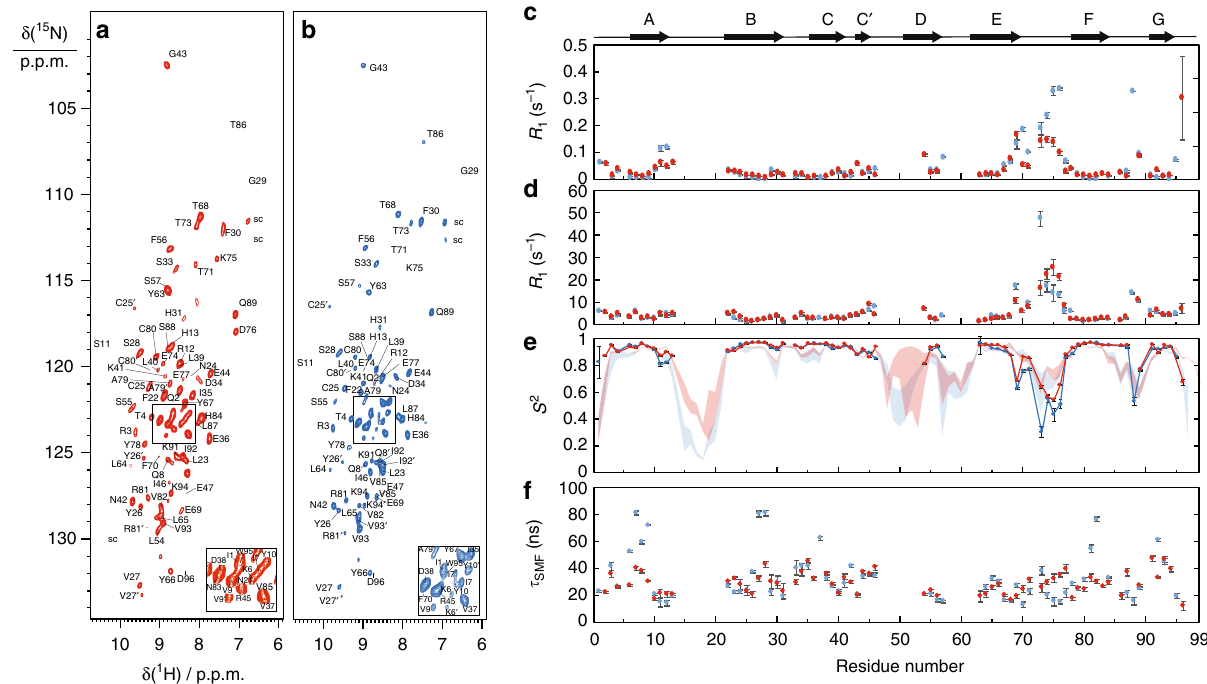
Fig. 2 Detection of fast local motions by 15 N R 1 and R 1 ρ relaxation experiments. 15 N – 1 H CP-based HSQC of wt- ( a ) and D76N- ( b ) [ 2 H, 13 C, 15 N] β -2 microglobulin with 100% reprotonation at the exchangeable sites recorded on an 800 MHz spectrometer at 60 kHz MAS rate (283 K, pH 5.5). All resonances were assigned using a set of experiments detailed in ref. 26 . The color code (red for wt and blue for D76N β 2m) is used for all the fi gures presented here. Site-speci fi c 15 N R 1 ( c ) and R 1 ρ ( d ) relaxation rates of the two proteins were used to calculate the order parameters S 2 ( e ) and the correlation time ( f ) with the model-free approach. The results of a 50 ns MD trajectory are plotted together with the experimental results in E (red and blue bundles). β 2m secondary structures are plotted on top of the panels. Experimental error bars (s.d.) were obtained from 1000 Monte Carlo